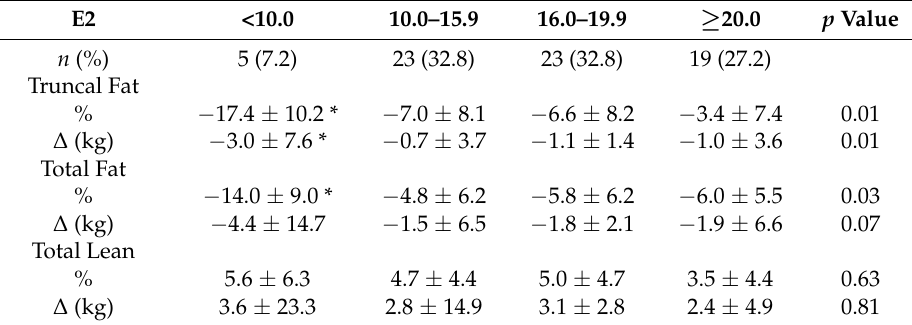
Table 4. Body Composition Changes after 6 Months of T Therapy.